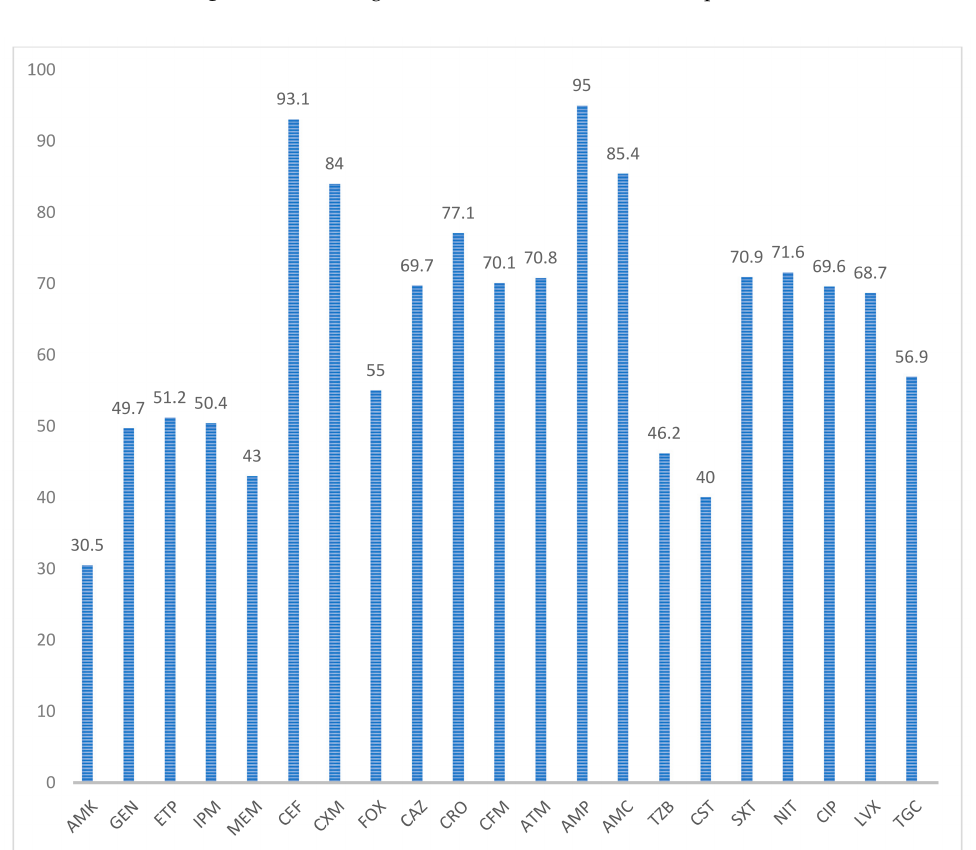
Figure 1. Gram-negative bacteria isolated from ICU patients.